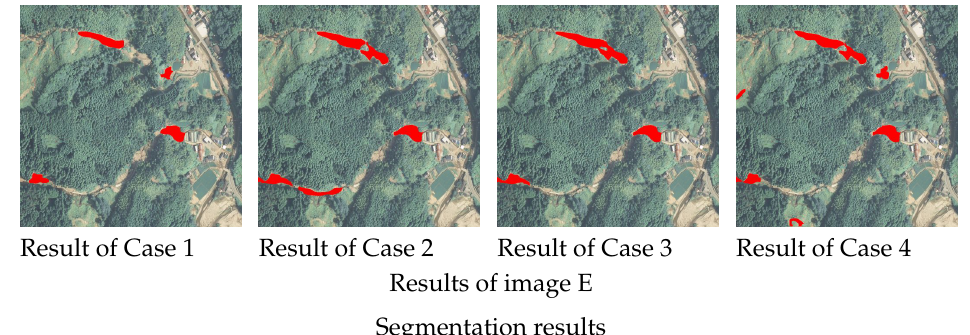
Figure 5. Segmentation results (Examples of partially undetectable cases). The images in first and second lines show the original aerial photographs, and the ground truth, which indicates the area of slope failure regions in red in the aerial photograph, respectively. The images in third to fourth line show the results of detecting slope failure regions for images D and E shown in the first line, respectively. The detection results are shown in the order of Case 1, 2, 3, and 4 from the left to right. Where the failure region is exceptionally detailed and is blocked due to being surrounded by trees or shadows such that it cannot be detected, even using human eyes, it may be difficult to judge.